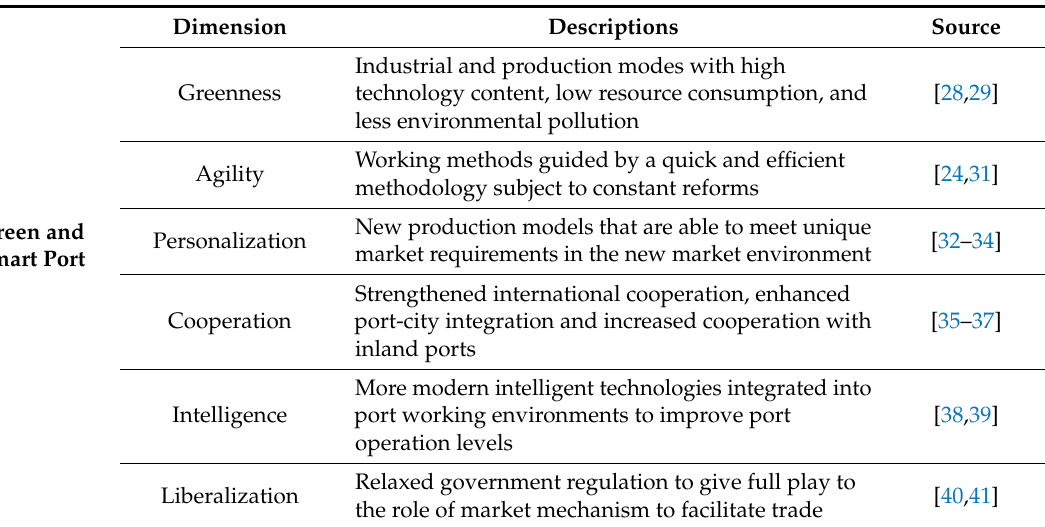
Figure 1. Concept map of a green and intelligent port integration. Table 1. The development concept for green and smart ports.